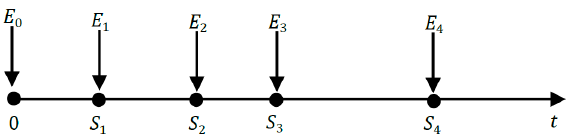
Figure 21. Energy harvesting communication model for solving STTM